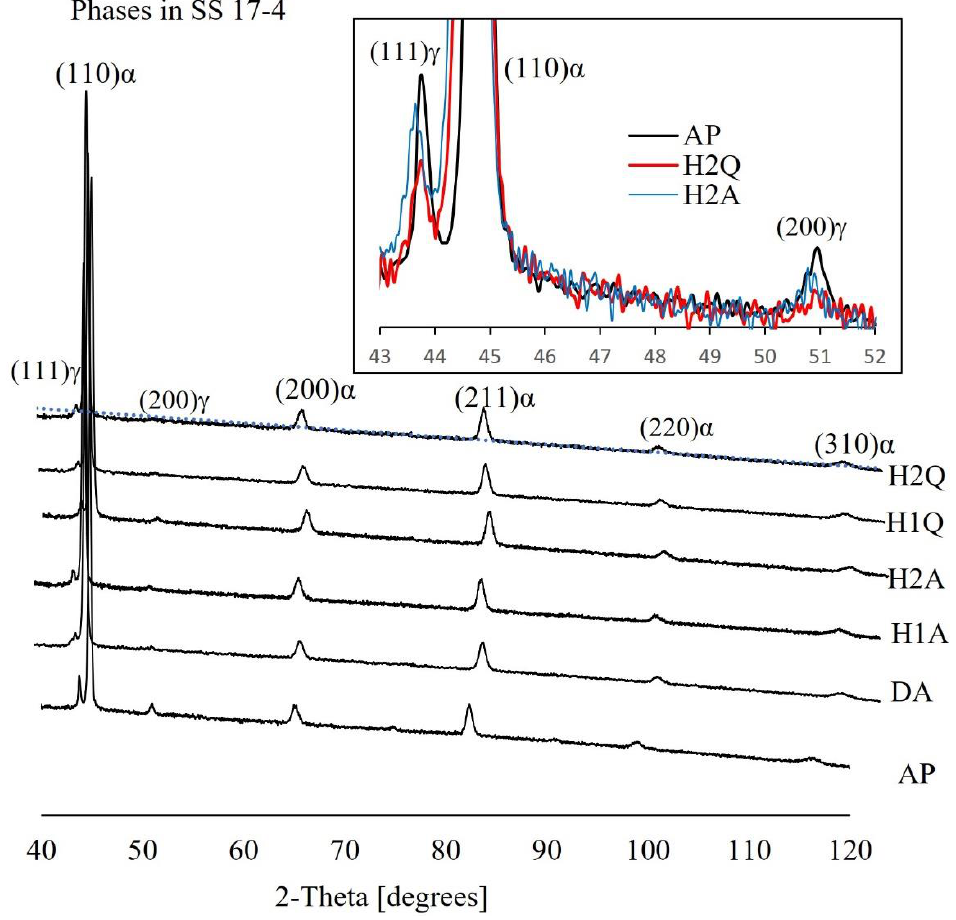
Figure 4. XRD diffractograms of the MfMX-17-4 ss samples before and after the heat treatment. The insert is the magnified view of the low-index peaks of the fcc crystal planes. 202